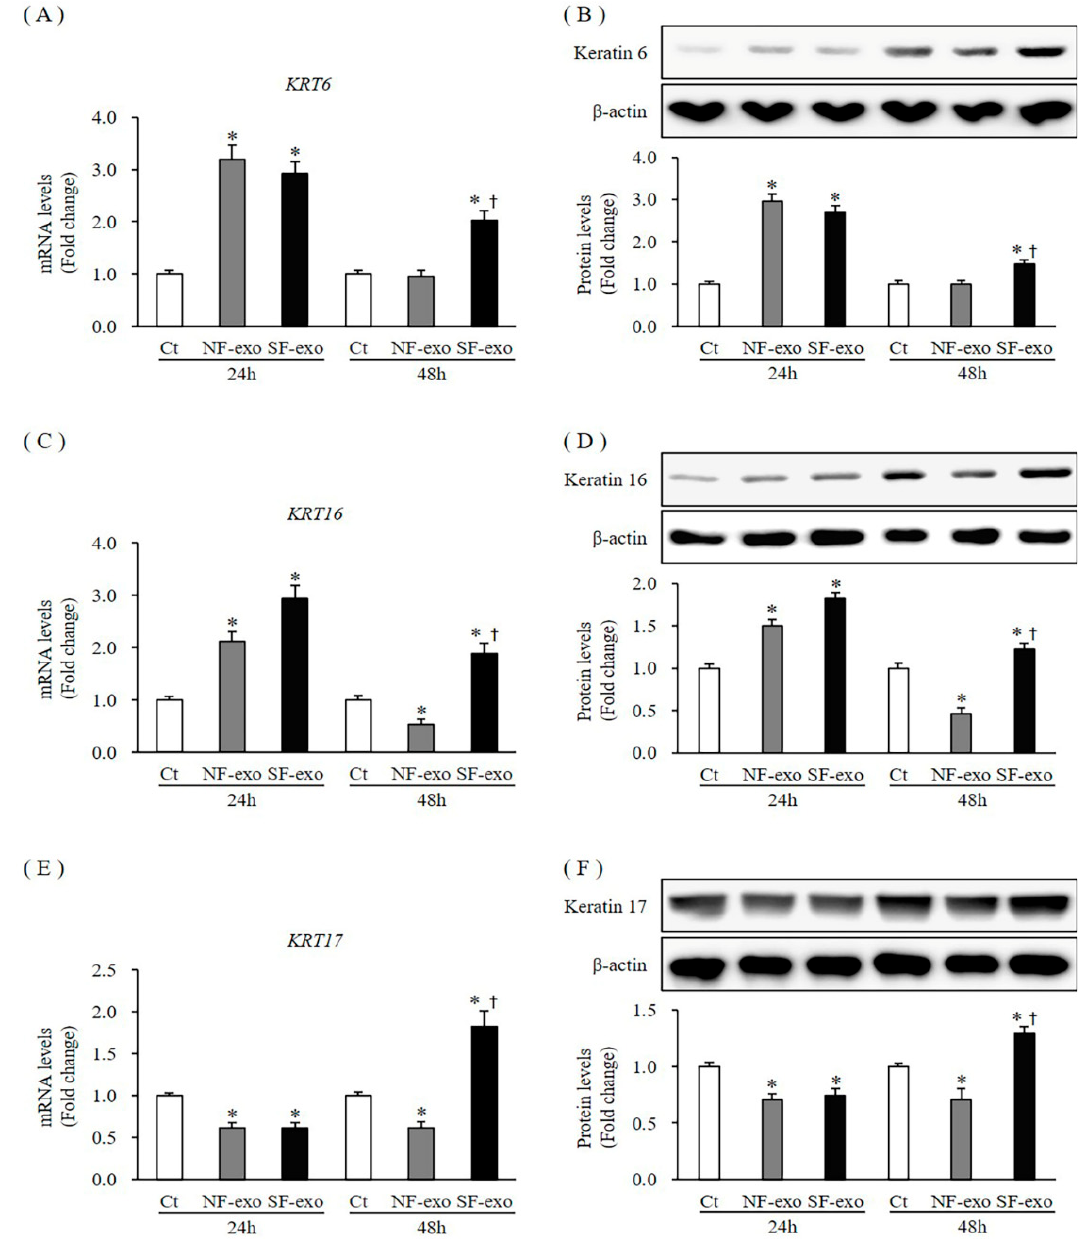
Figure 3. Expression of activation markers in NHKs after NF- and HTSF-exosome treatment. The mRNA and protein expression of keratin 6 ( KRT6 ; A , B ) in NHKs increased significantly at 24 h. However, these levels were unchanged at 48 h after treatment with 100 µg/mL NF-exosomes but increased in NHKs when treated with HTSF-exosomes compared with that in the control cells. The mRNA and protein expression of KRT16 ( C , D ) increased at 24 h and decreased at 48 h after treatment with 100 µg/mL NF-exosomes but increased when treated with HTSF-exosomes. The mRNA and protein levels of KRT17 ( E , F ) in NHKs decreased at 24 h after treatment with NF- and HTSF-exosomes. The mRNA and protein levels of KRT17 decreased and increased at 48 h after treatment with NF- and HTSF-exosomes, respectively, compared with those in control cells. * p < 0.05 for NF- or HTSF-exosome-treated cells versus the corresponding matched control cells. † p < 0.05 for HTSF-exosome-treated cells versus NF-exosome-treated cells. Data represent the mean ± SD; n = 4. Ct, DPBS-treated control cells; NHK, normal human keratinocytes; NF, normal tissue-derived fibroblast; HTSF, hypertrophic scar tissue-derived